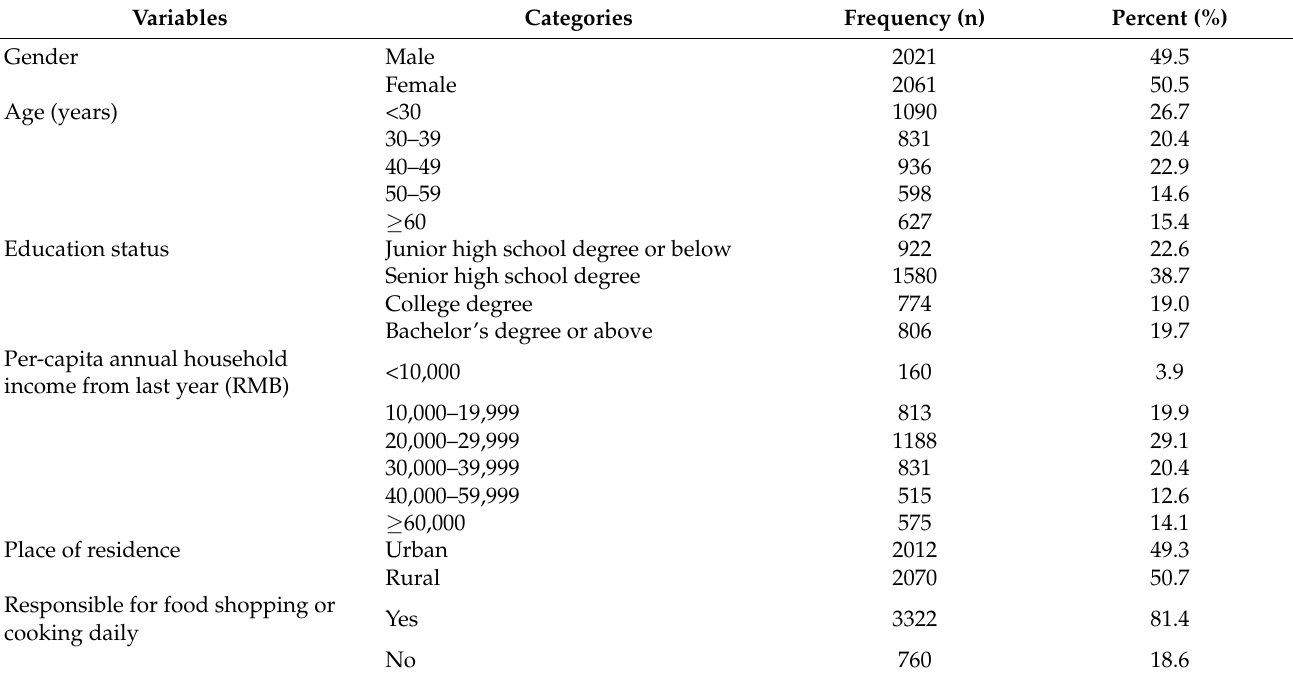
Table 1. Descriptive statistics of consumers’ demographic characteristics.